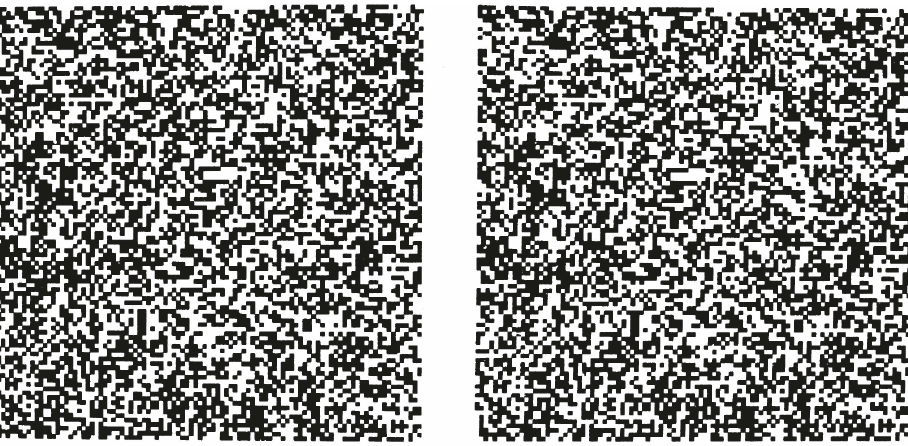
Figure 10: A random-dot stereogram from [91, Figure 2.4-1], reproduced with permission of Alcatel-Lucent/Bell